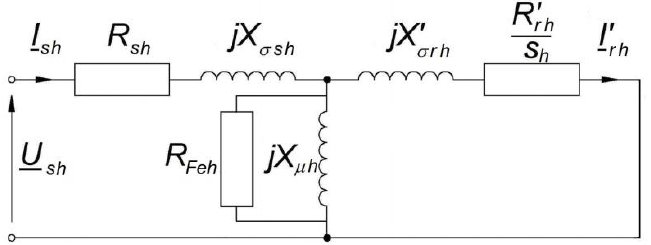
Figure 1. Equivalent circuit of squirrel-cage motor for harmonic h ; s h = (+/ − h ∙ ω 1 − ω )/(+/ − h ∙ ω 1 ) ≈ 1. For high frequencies of rotating harmonics ( h ≥ 5), the magnetizing currents I µ h